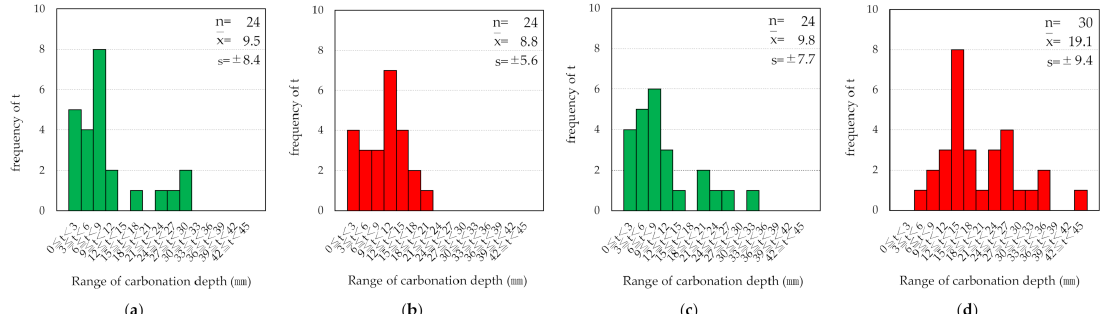
Figure 6. Distribution of carbonation depth below and beside the windows in the northeast outer wall of Bldg. A. ( a ) Carbonation depth of walls beside windows covered with external insulation. ( b ) Carbonation depth of walls beside windows without external insulation. ( c ) Carbonation depth of walls under windows covered with external insulation. ( d ) Carbonation depth of walls under windows without external insulation.